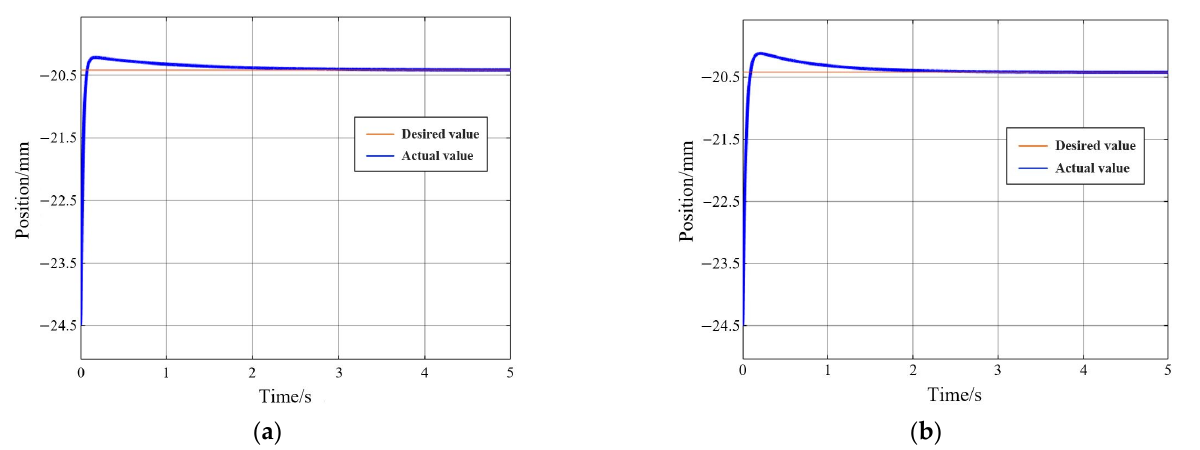
Figure 6. Step response simulation of different controllers with the same electromagnetic actuation structure. ( a ) Step response simulation of neural network PID controller; ( b ) Step response simulation of model-based controller.